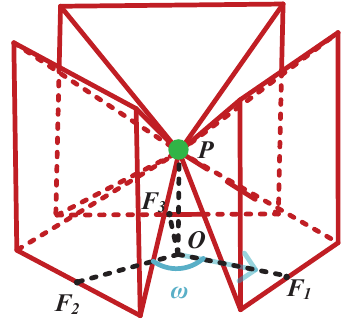
Figure 7. The perception